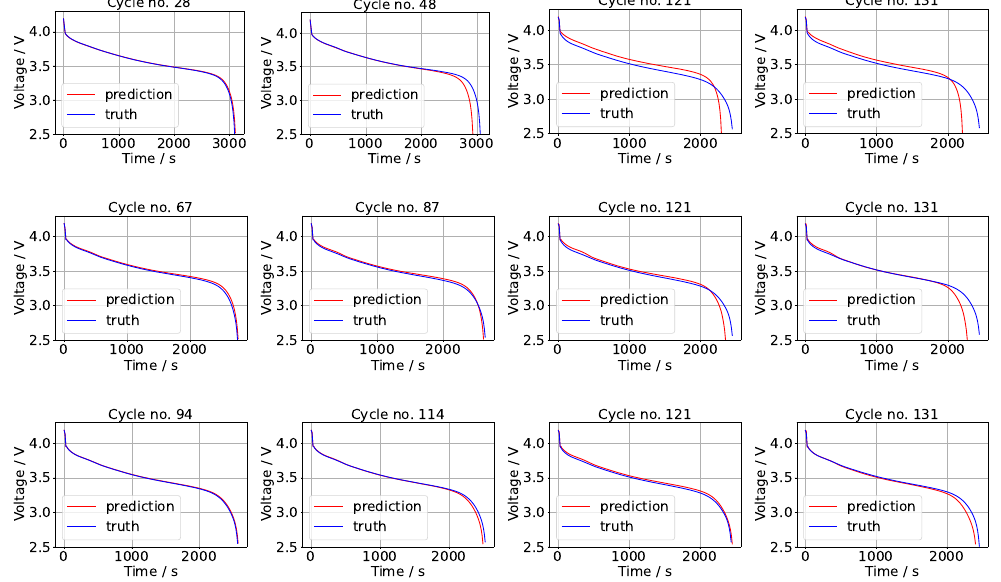
Figure 4. Voltage results for the data set B0018 for different numbers of training points. From the top row to the bottom row, 20%, 50% and 70% of the data is